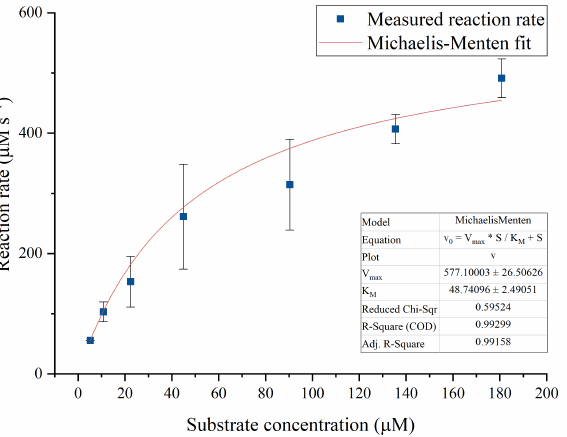
Figure 6. Effect of substrate concentration on the reaction rate. The orange line indicates the calculated rates of Michaelis–Menten kinetics fitted to the measured reaction rates (blue) at the first filtration cycle. Error bars represent the standard deviation of triplicate